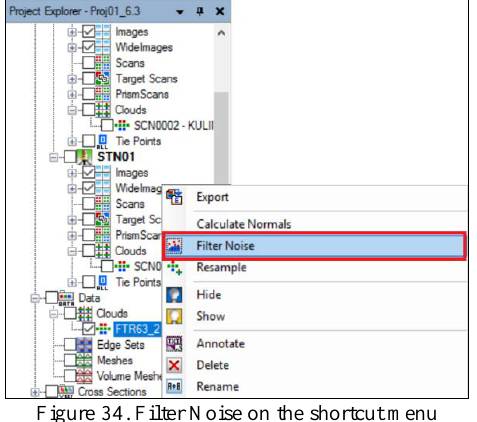
Figure 34. Filter Noise on the shortcut menu